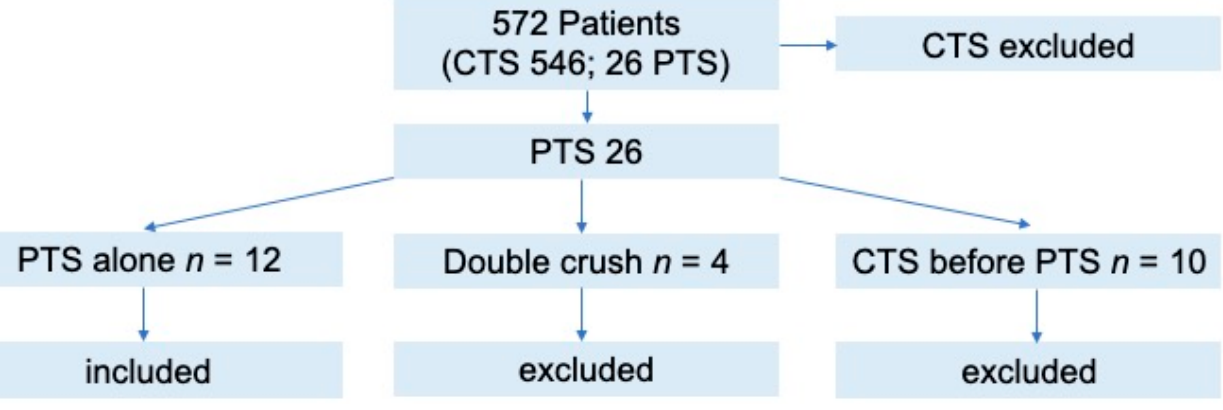
Figure 1. Patient flow-chart.